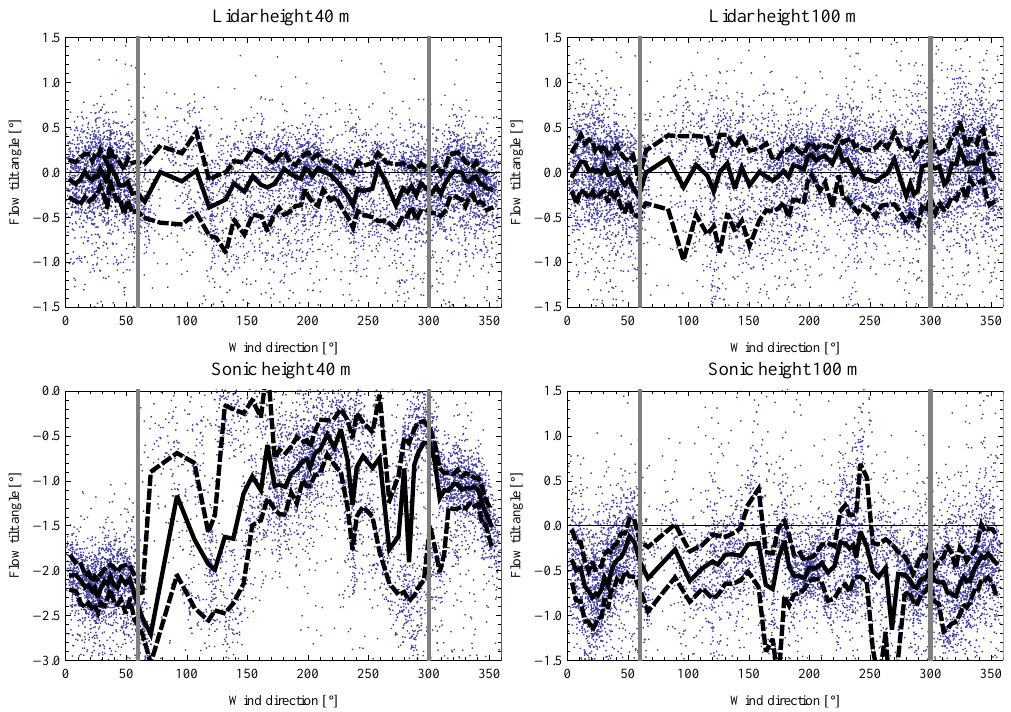
Fig. 5. Comparison of lidar (left) and sonic (right) 30min mean flow tilt angles at Bolund using all data.